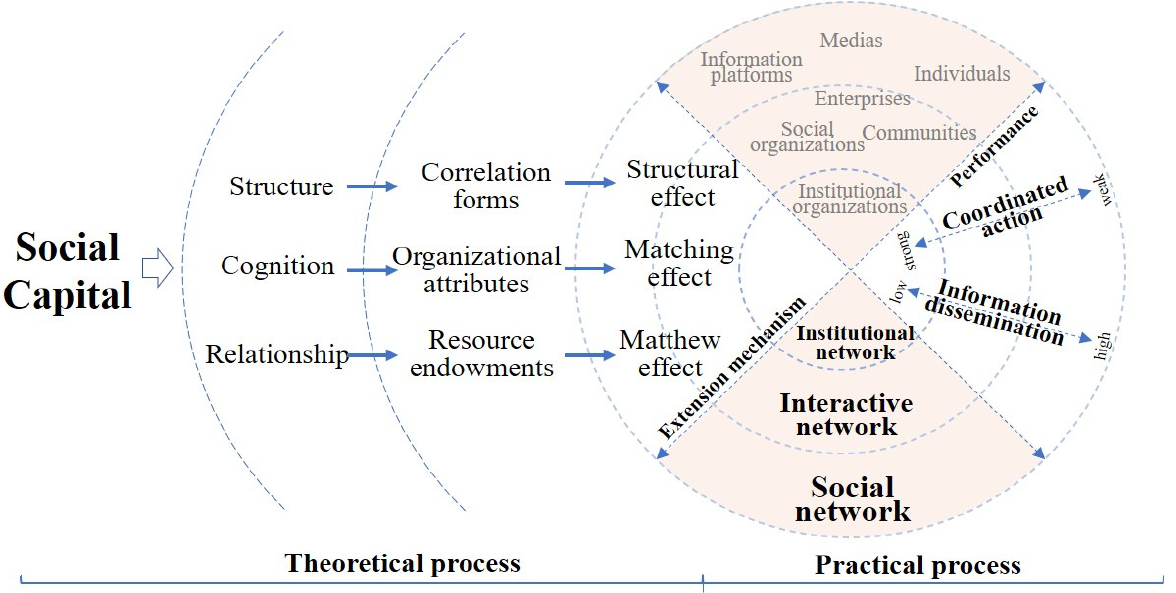
Figure 1. The research framework.